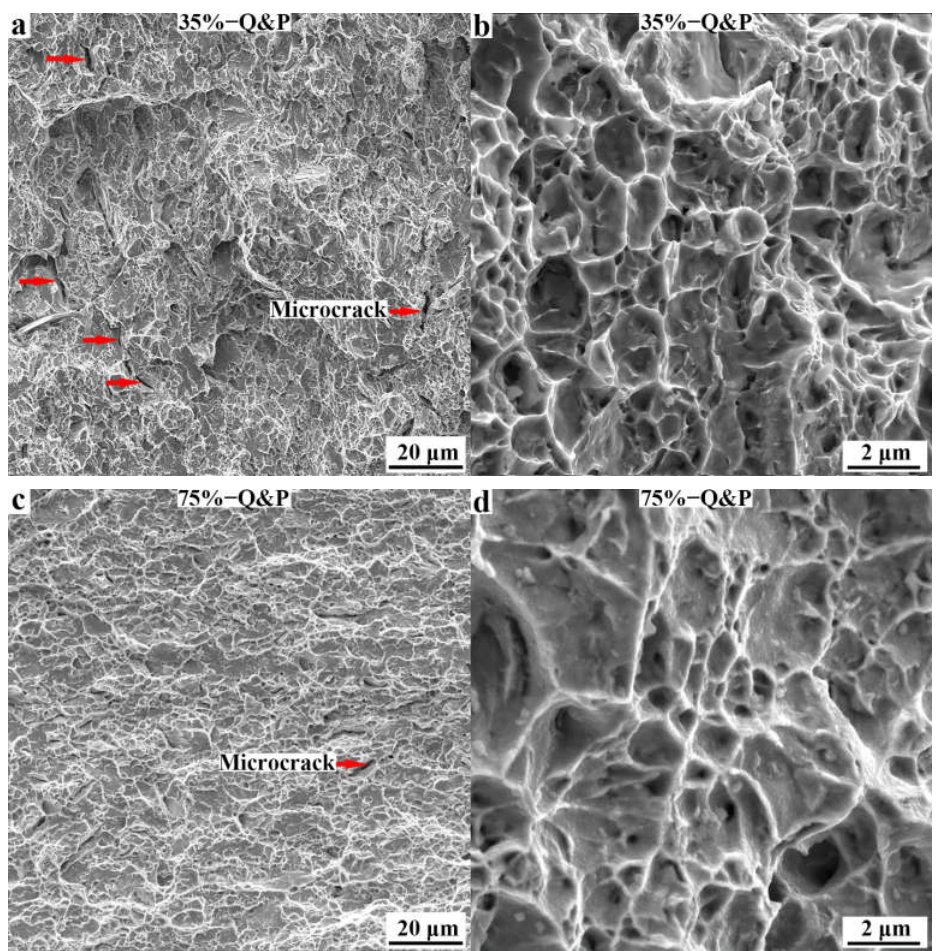
Figure 9. Low and high magnification fractography of fracture surfaces of ( a , b ) 35%−Q&P sample and ( c , d ) 75%−Q&P sample.